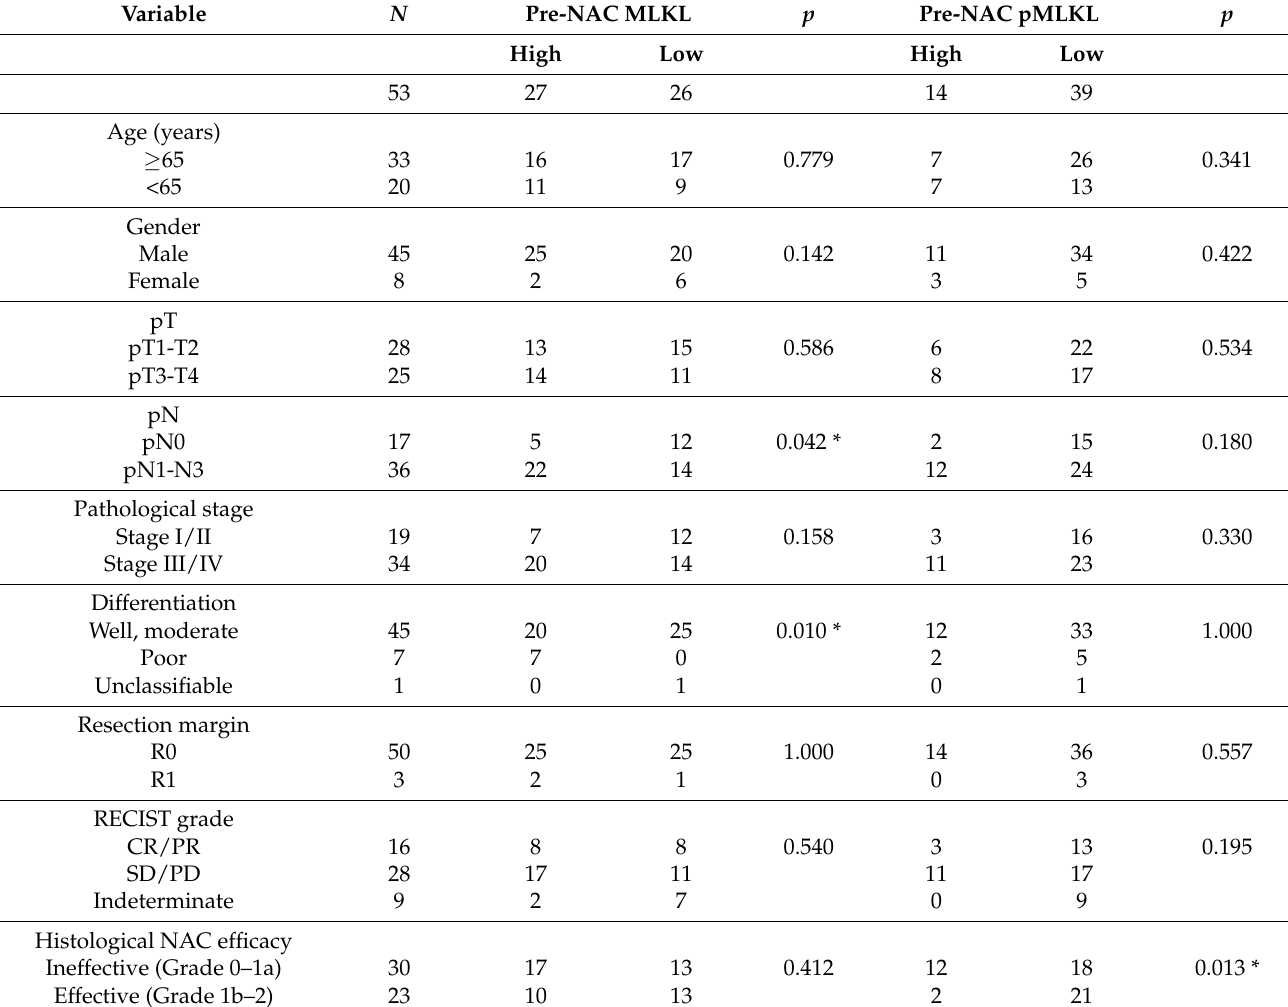
Table 4. Pre-NAC expression status of the markers and its correlation with clinicopathological